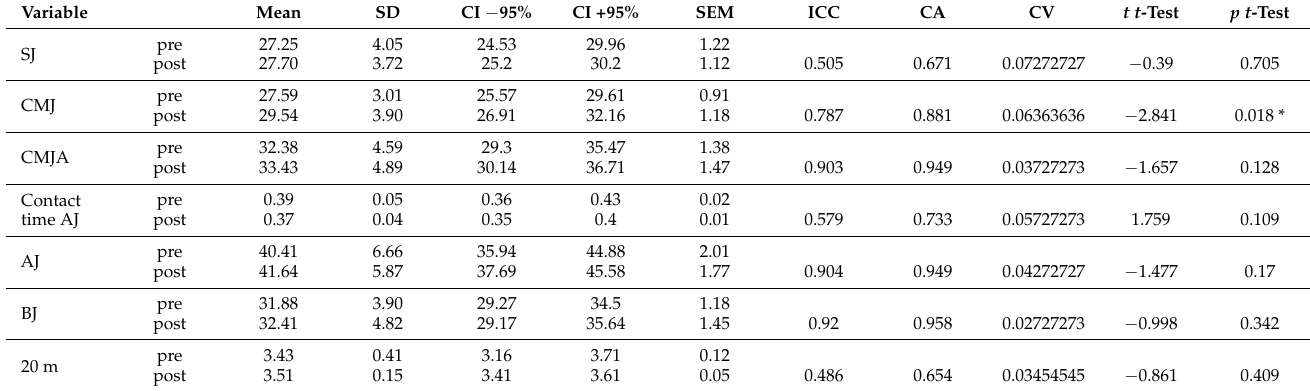
Table 2. Results of motor tests of volleyball female athletes measured before and after the training period. Mean values of variables measured pre- and post-training were compared using t